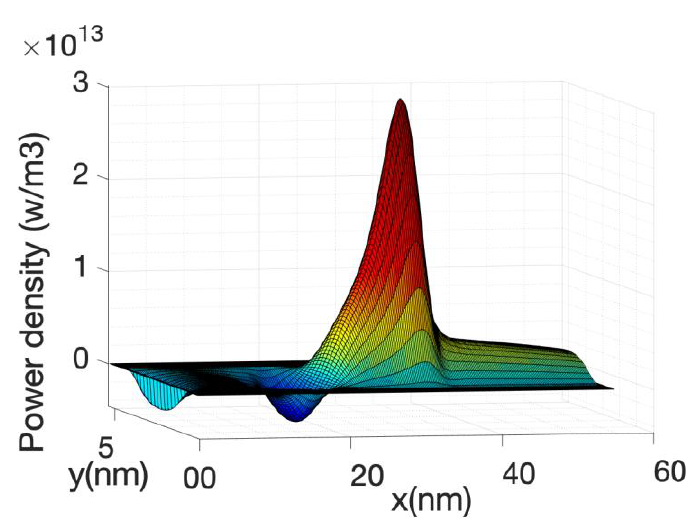
Figure 12. Heat source due to hot electrons at Vg = 0.6 V.